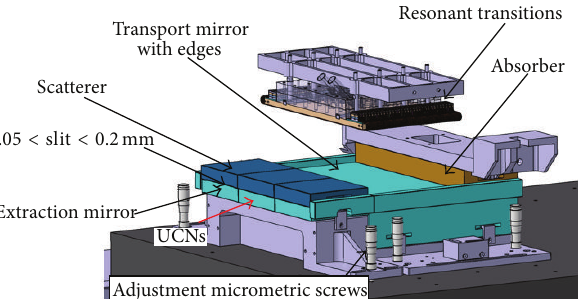
Figure 16: Schematics and pictures of the optical elements. The extraction mirror and the scatterer have the same sizes ( 300 × 100 × 20 mm 3 ) and each consists of 3 pieces of 100 × 100 × 20 mm 3 glued together. The mean roughness of the extraction mirror (floor) is very low (0.5nm) to allow for specular bouncing, whereas the mean roughness of the scatterer (ceiling) is intentionally high (5.6 𝜇 m) to allow UCNs with too high vertical velocity to be diffused back. The transport mirror ( 300 × 250 × 70 mm 3 ) has a surface mean roughness of 0.5 nm and a planarity of 80 nm. The absorber mirror is 300 × 90 × 30 mm 3 .